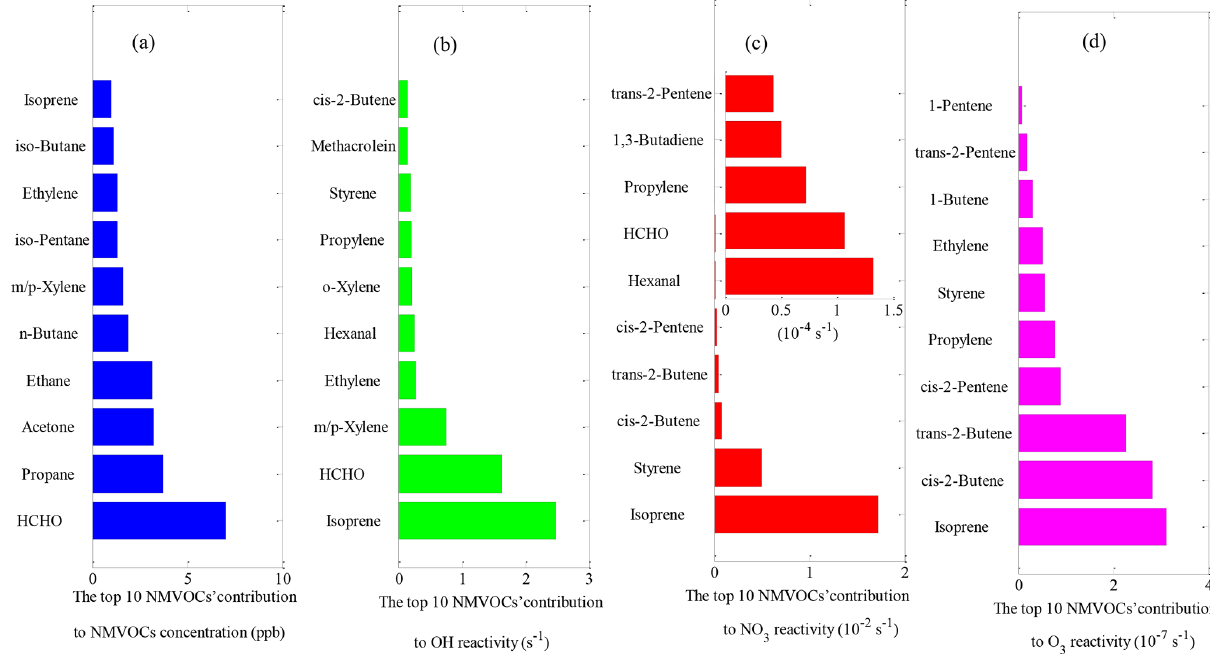
Figure 3. The top 10 NMVOCs’ contribution to (a) total NMVOC concentration, (b) OH reactivity, (c) NO 3 reactivity and (d) O 3 reactivity during the field campaign at Xianghe from 6 July to 6 August 2018.